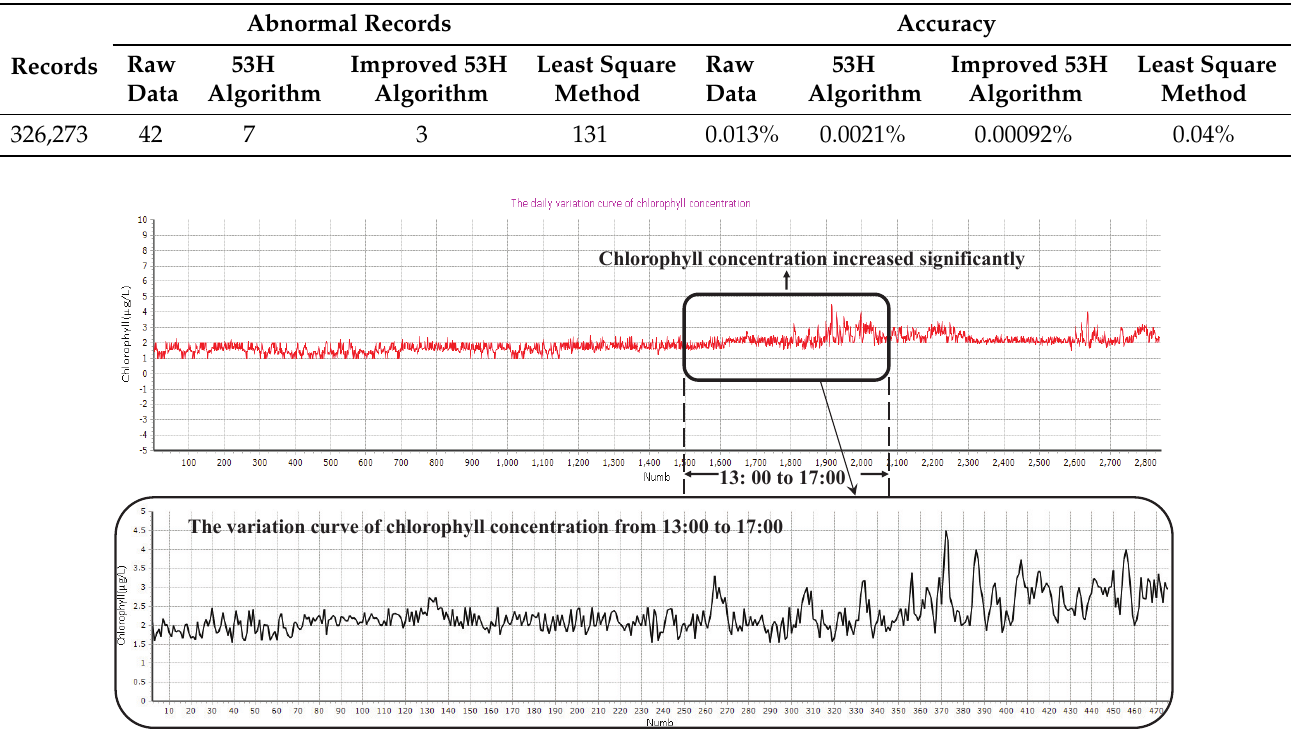
Figure 16. The daily variation curve of chlorophyll concentration on 19 August